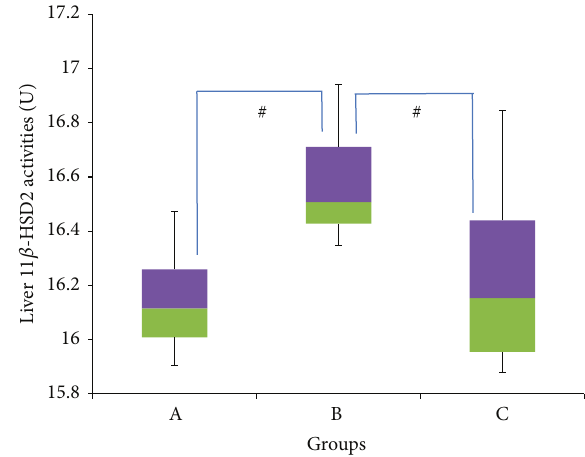
Figure 8: 11 𝛽 -HSD 2 activities in the liver of rats in groups A, B, and C at the end of the four-week treatment period. # Significant difference ( 𝑃 < 0.05 ) between denoted groups. Group A: control (HSD/HFD); group B: stress + HSD/HFD; group C: stress + GA + HSD/HFD. Abbreviations: GA: glycyrrhizic acid, HSD: high- sucrose diet, and HFD: high-fat